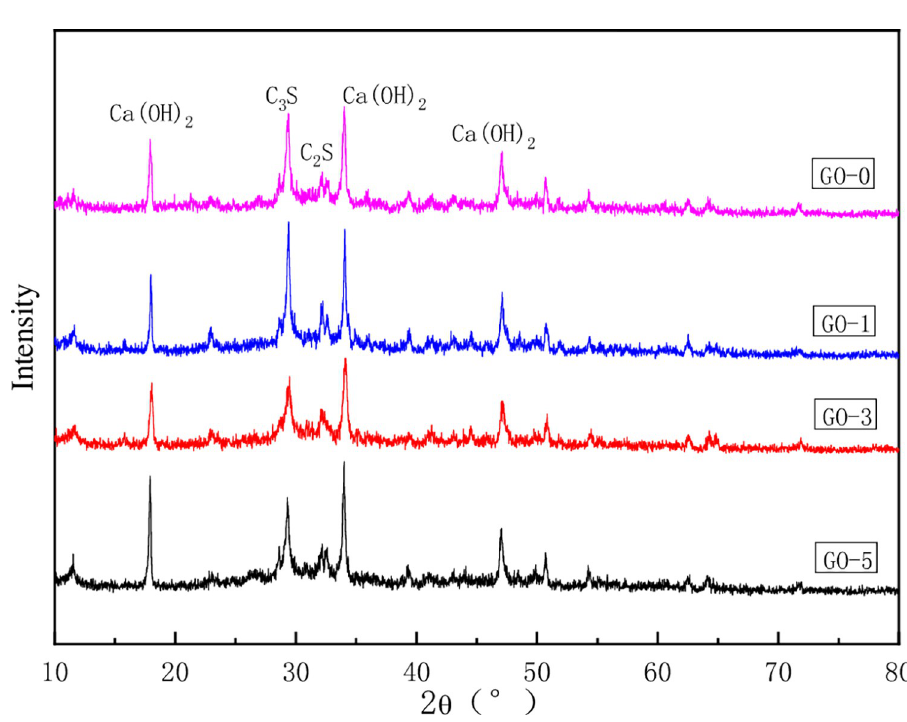
Fig 14. XRD of specimens after 28 days curing.